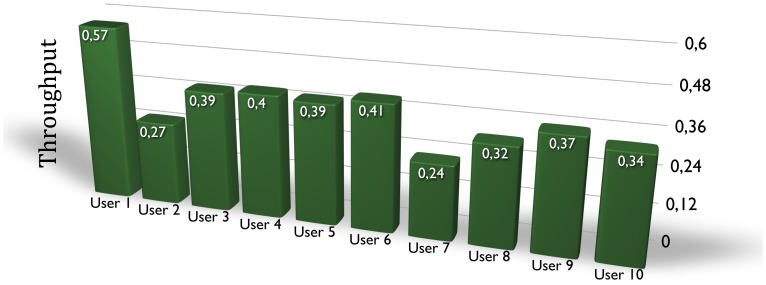
Throughput results.